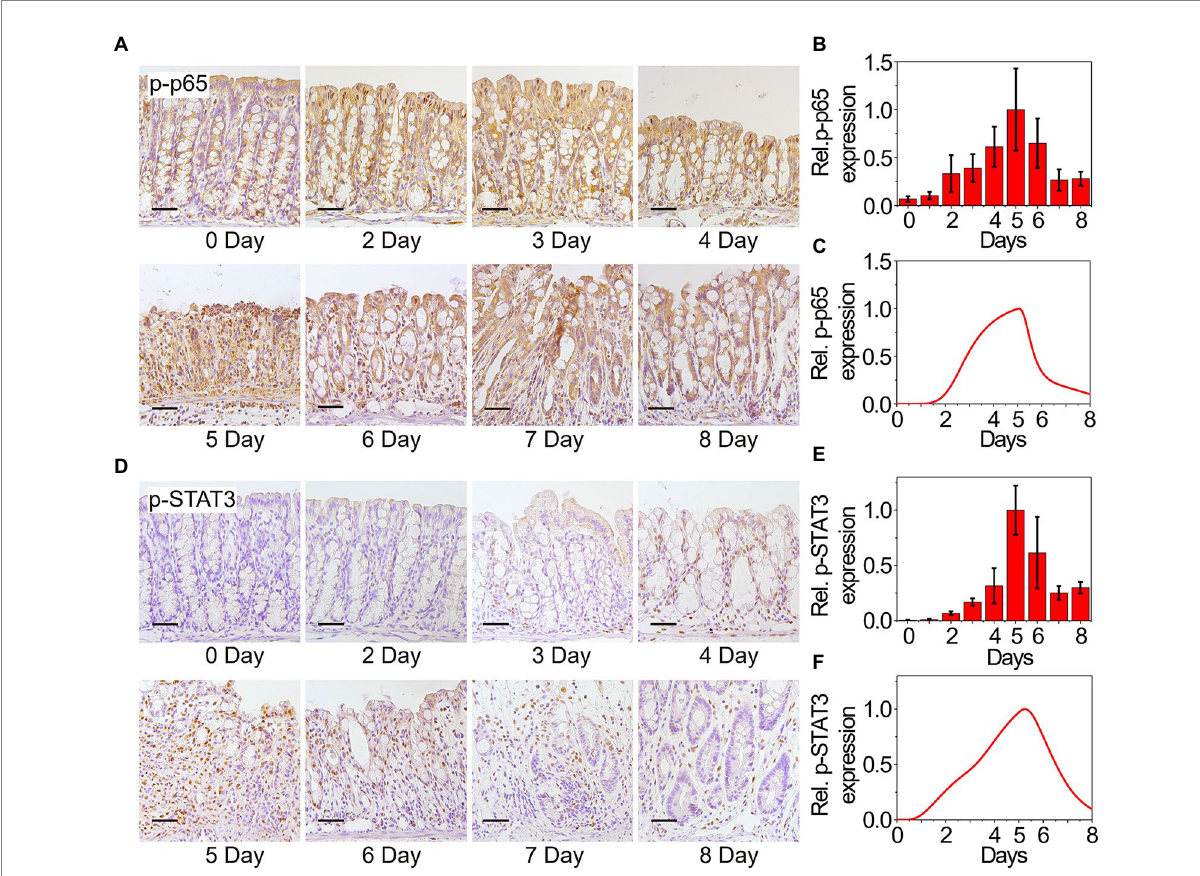
FIGURE 2 Experimental and modeling results of p65 and STAT3 activation. (A) Immunohistochemistry for p65 in the colons from WT mice at the indicated time points following DSS treatment. n = 3 at each time point. (B) Statistical histogram of experimental immunohistochemistry results for p65 in panel (A) . (C) Simulation results of p-p65 expression in WT model over time after DSS treatment. P65 is phosphorylated when it is transferred to the nucleus. (D) Immunohistochemistry for p-STAT3 in the colons from WT mice at the indicated time points following DSS treatment. n = 3 at each time point. (E) Statistical histogram of experimental immunohistochemistry results in panel (D) . (F) Simulation results of p-STAT3 expression in WT model over time after DSS treatment. Here, the results in (B,C,E,F) are normalized to the corresponding maximum of p-p65 and p-STAT3,